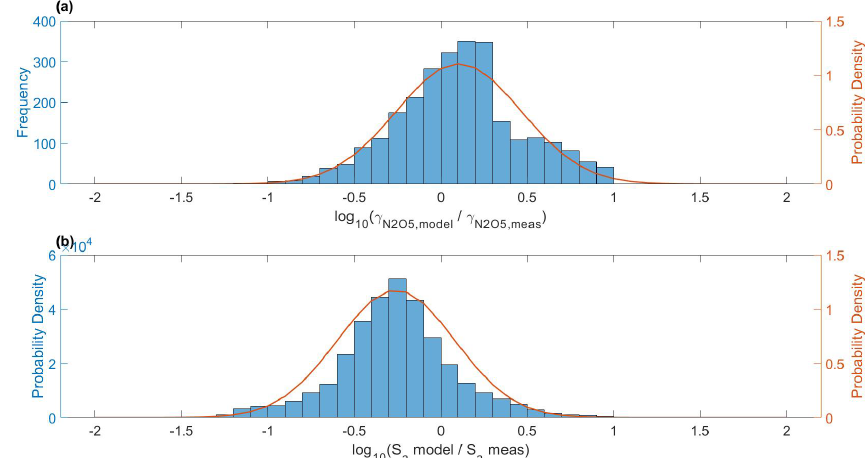
Figure 14. Normalized probability density functions for the log 10 of the model-to-measurement ratio in (a) γ (N 2 O 5 ) from the WINTER campaign and (b) particle surface area concentration, S a , from this